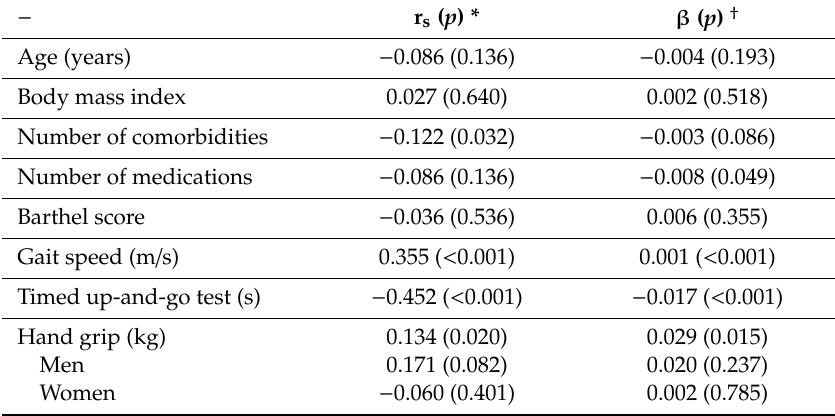
Table 2. Relationship between the intracellular water content (ICW) / lean mass (LM) ratio and numerical clinical and functional